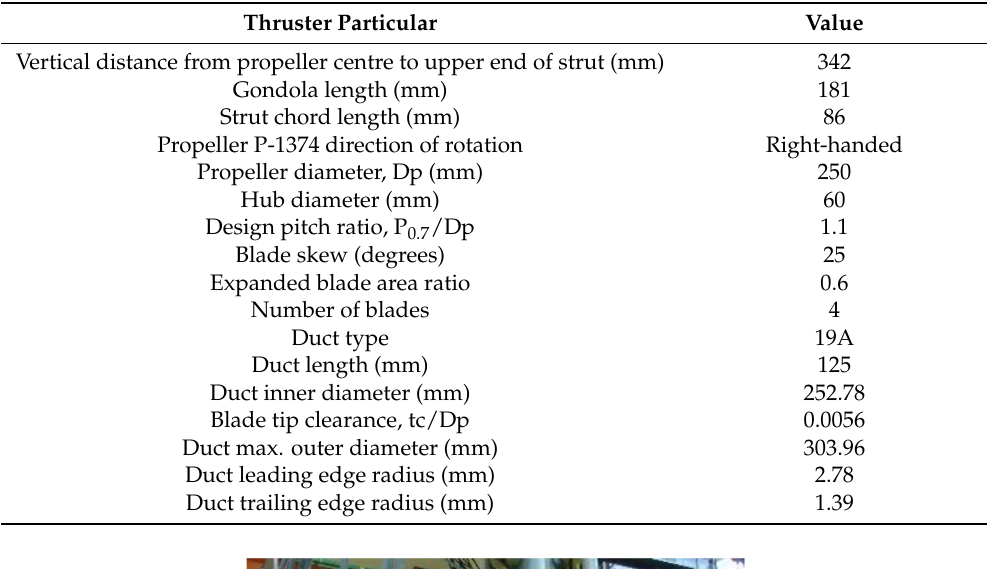
Table 1. Main particulars of the tested propulsor model.